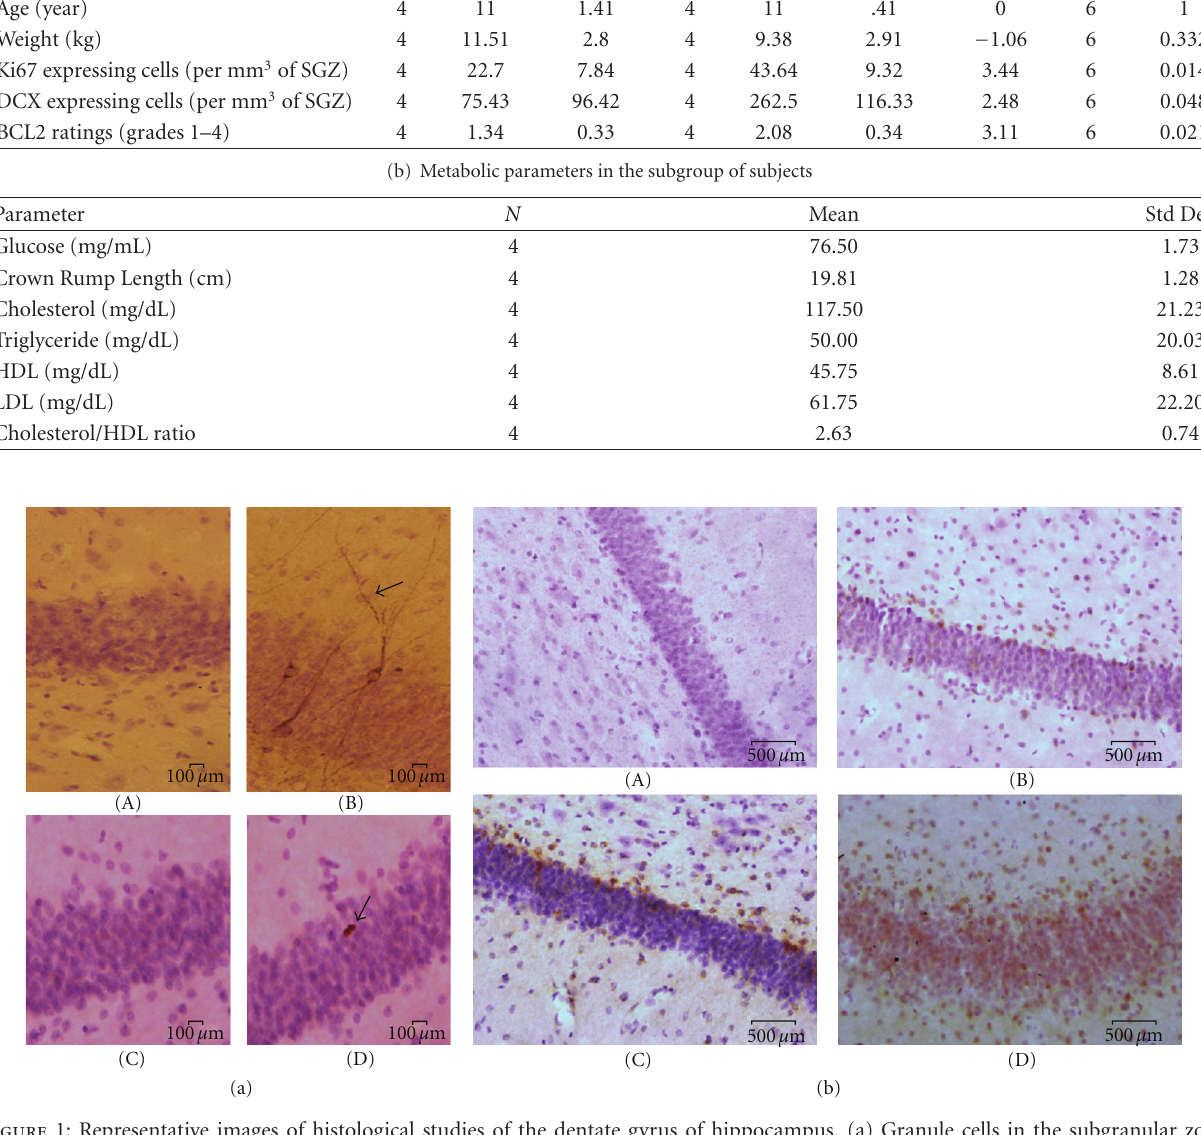
Figure 1: Representative images of histological studies of the dentate gyrus of hippocampus. (a) Granule cells in the subgranular zone (SGZ) positive (arrows) for DCX and Ki67. (A) represents negative control for DCX. (B) represents positive staining for DCX. (C) represents negative control for Ki67. (D) represents positive staining for Ki67. Scale bar: 100 µ m. (b) Images of BCL2-labeled cells in the SGZ. BCL2 gene expression in the SGZ was rated using a semiquantitative according to a 4-point scale. (A) represents no labeling; rated as 0. (B) represents light labeling of individual cells; rated as 1. (C) represents heavy, yet noncontinuous labeling of BCL-2 along the SGZ; rated as 2. (D) represents intense labeling forming a continuous band along the entire length of the SGZ; rated as 3. Scale bar: 500 µ